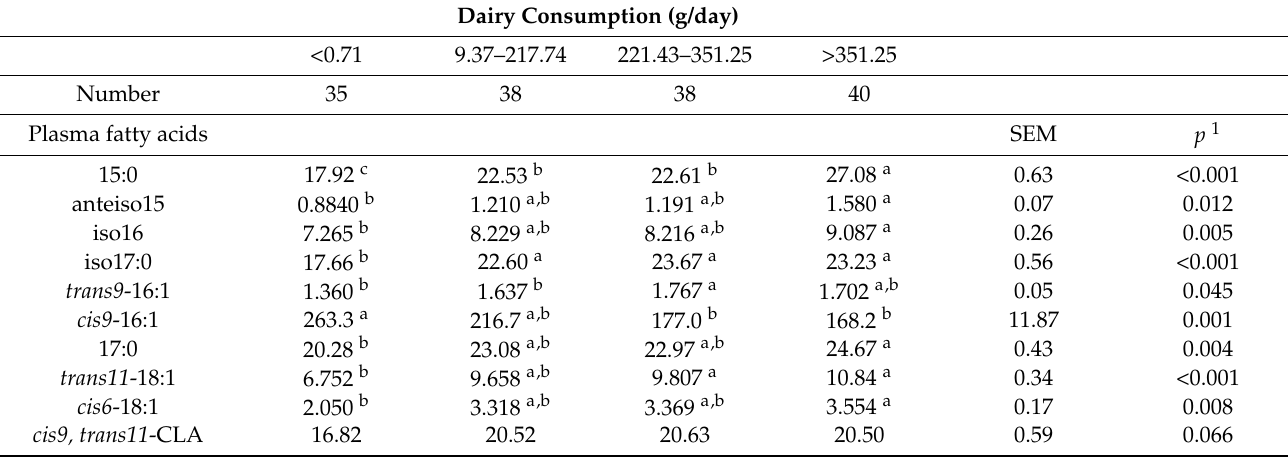
Table 4. Fatty acid concentration means ( µ mol/L) in plasma samples of participants in the observational study and the standard error of the mean